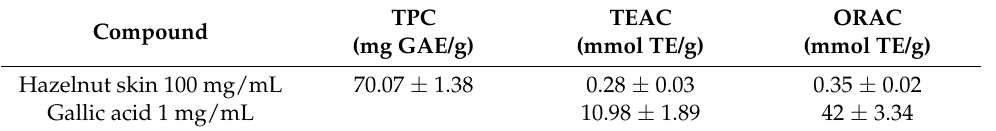
Table 3. Total phenolic content (TPC) and antioxidant capacity (TEAC and ORAC). TPC of Hazelnut skin expressed as mg of gallic acid per g of fresh weight. TEAC and ORAC expressed as mmol of trolox per g of fresh weight. All values are expressed as mean ± SD ( n = 3). TPC TEAC ORAC Compound (mg GAE/g) (mmol TE/g) (mmol TE/g) Hazelnut skin 100 mg/mL 70.07 ±